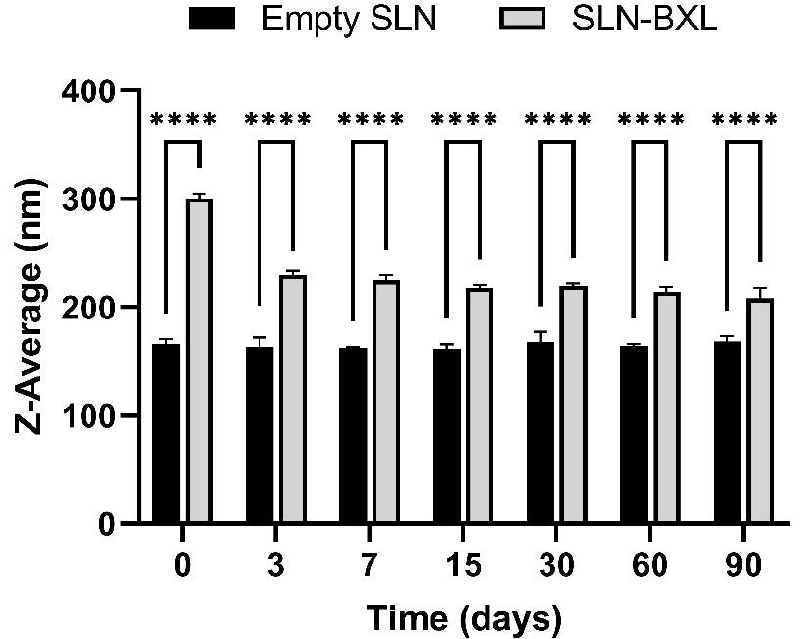
Figure 1. SLN mean particle size. The results are shown as mean ± standard deviation. Confidence intervals calculated by two-way ANOVA: **** = p < 0.0001.